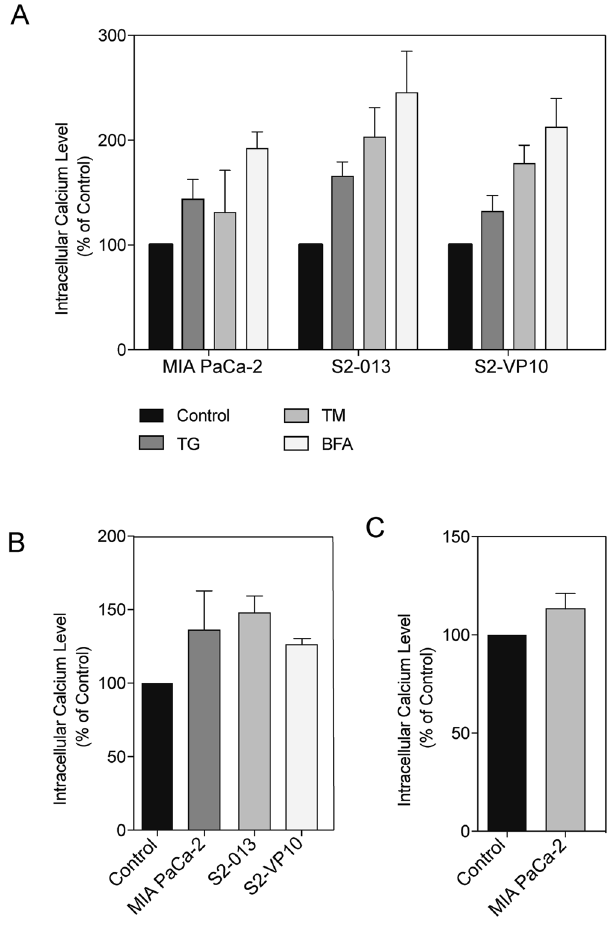
Figure 4. Chronic ER stress results in a sustained accumulation of cytosolic calcium. MIA PaCa-2, S2-VP10, and S2-013 cells treated with ( A ) known ER stress inducers and measured cytosolic calcium after 24 hours of treatment, and ( B ) mithramycin and measured cytosolic calcium after 24 hours of treatment, and ( C ) silenced with siSp1 measured cytosolic calcium after 24 hours of